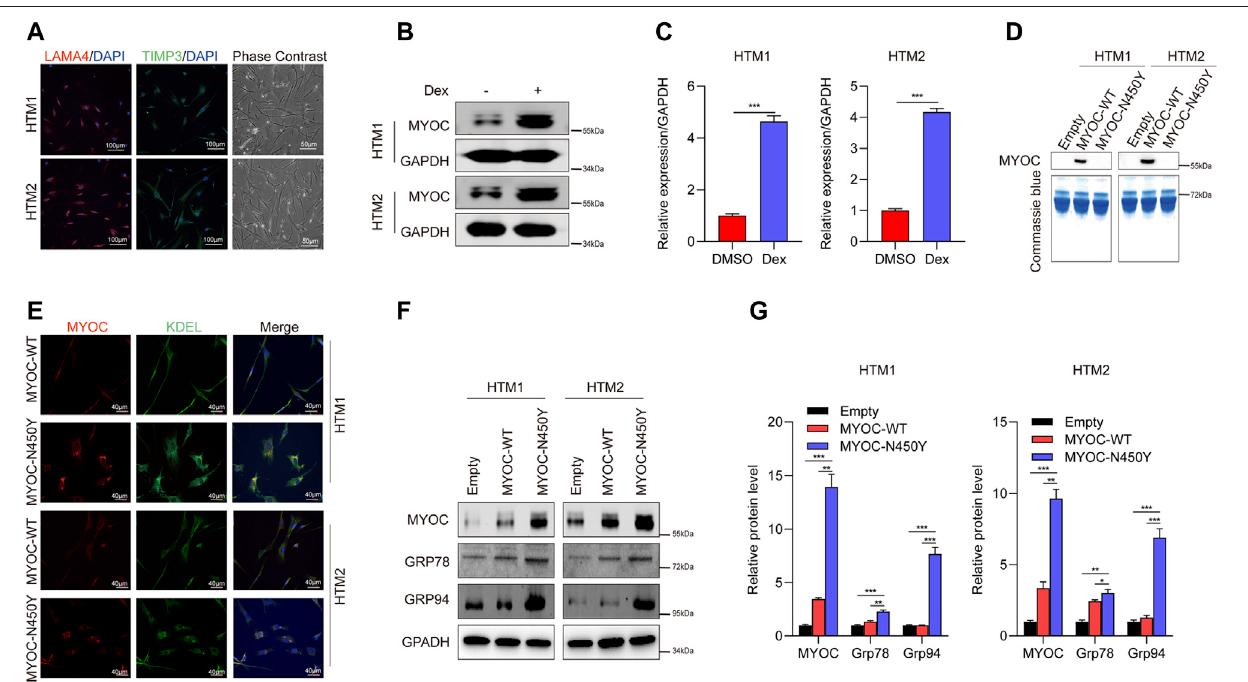
FIGURE 1 | Non-secretionofmutantMYOC-inducedERstress. (A) Immuno fl uorescencestainingofLAMA4(red)and TIMP3(Green)andphasecontrastimagesinHTM cells. (B) Western blot detection of MYOC and GAPDH with or without dexamethasone treatment. (C) Bands intensity analysis in (B) using ImageJ software. ***, p < 0.001. (D) WesternblotanalysisofMYOCinculturemediumofHTMcellsoverexpressingMYOC-WTorMYOC-N450Y (E) .Immuno fl uorescencestainingofMYOC(red)andKDEL(green)in HTM cells overexpressing MYOC-WT or MYOC-N450Y. (F) Western blot detection of MYOC, Grp78, Grp94 and GAPDH in HTM cells overexpressing MYOC-WT or MYOC-N450Y (G) . Band intensity analysis in (F) using ImageJ software. *, p < 0.05; **, p < 0.01; ***, p < 0.001. Empty: empty vector lentiviruses; MYOC-WT: lentiviruses expressing wild type myocilin gene; MYOC-N450Y: Lentiviruses expressing N450Y mutant myocilin gene.